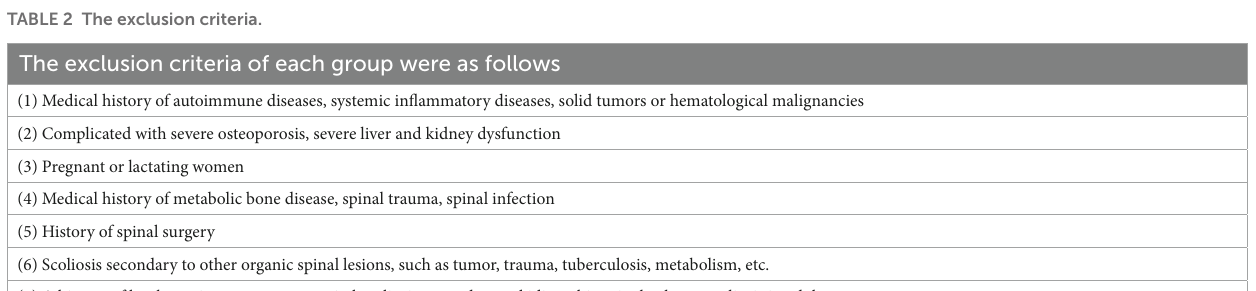
TABLE 2 The exclusion